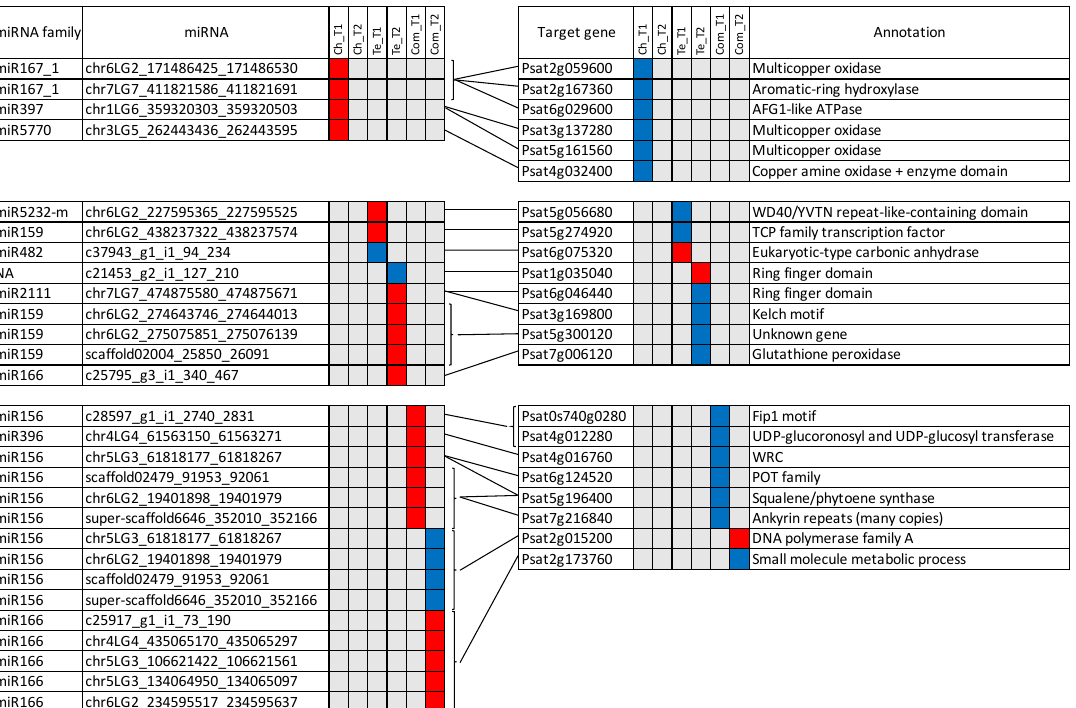
Figure 6. Discordant patterns of significant differential expression for miRNAs and their putative mRNA targets. Ch, Te and Com, respectively represent Ch-specific, Te-specific and common differ- ential cold-response. Down- and up-regulated mRNAs and miRNAs are shown in blue and red, respectively. Lines joining miRNAs and mRNAs represent putative miRNA-target relationships.